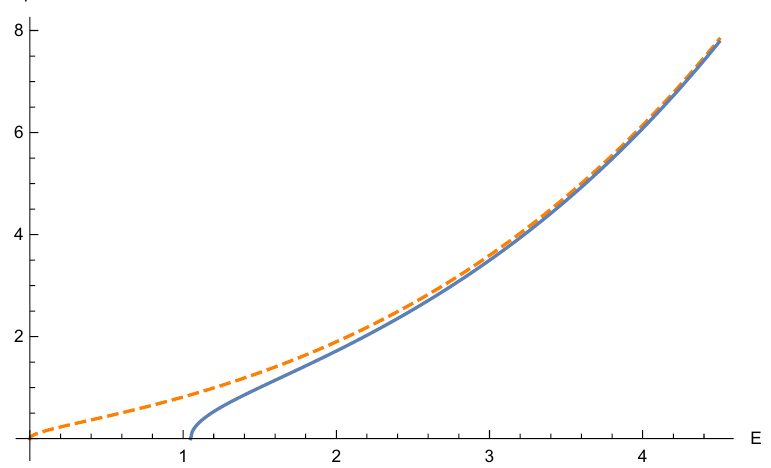
Figure 4. Plot of the eigenvalue density ρ 0 ( E ) for t = 3 , z = 1 , g s = 1 (blue solid curve). The orange dashed curve represents the pure JT gravity density of states in